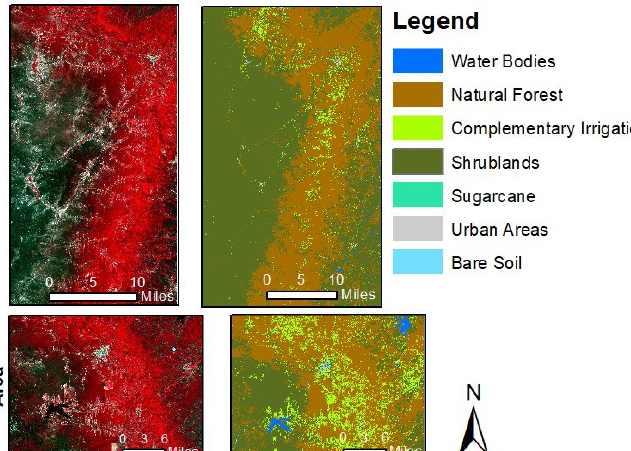
Figure 4 . False Color composition (NIR, Red, Green), and result of the classification for training area in the region of Western Ceará